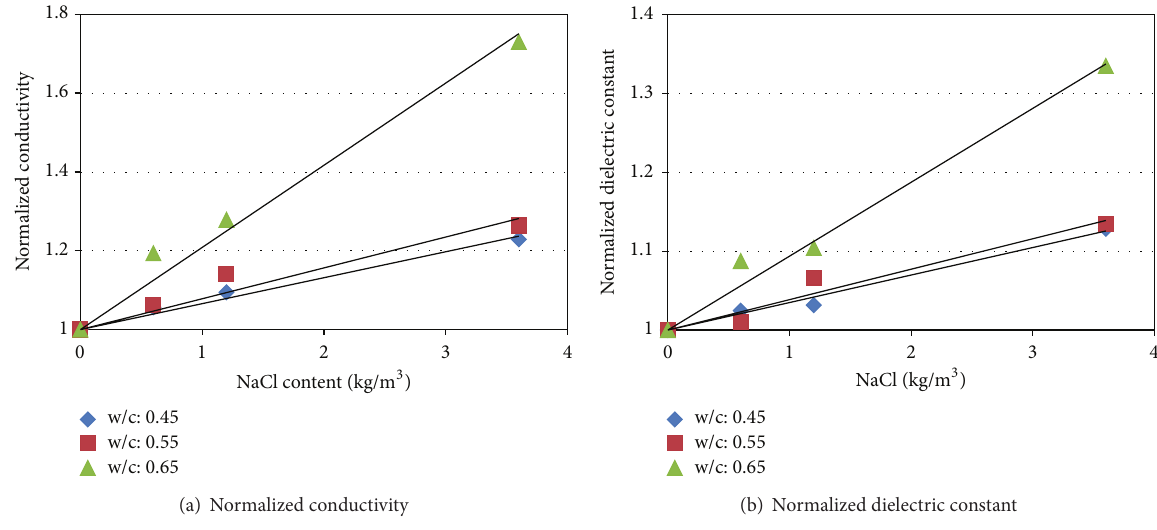
Figure 12: Increasing ratios of EM properties with chloride contents.